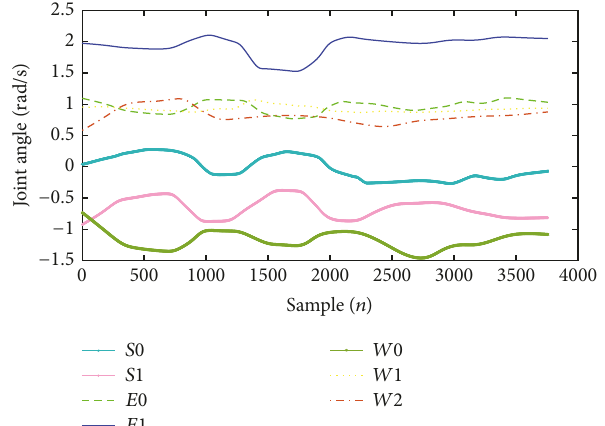
Figure 9: The seven joint angles of the Baxter robot right arm.